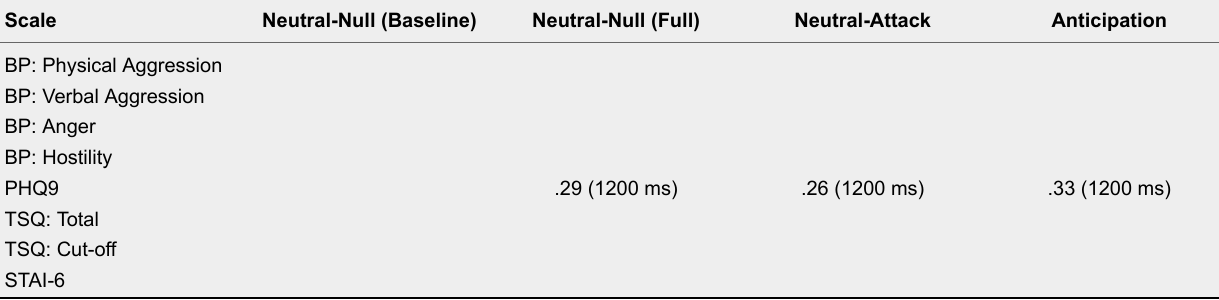
Significant Correlations Involving Contrast Scores and Questionnaire Data: A. Reaction Time Scale